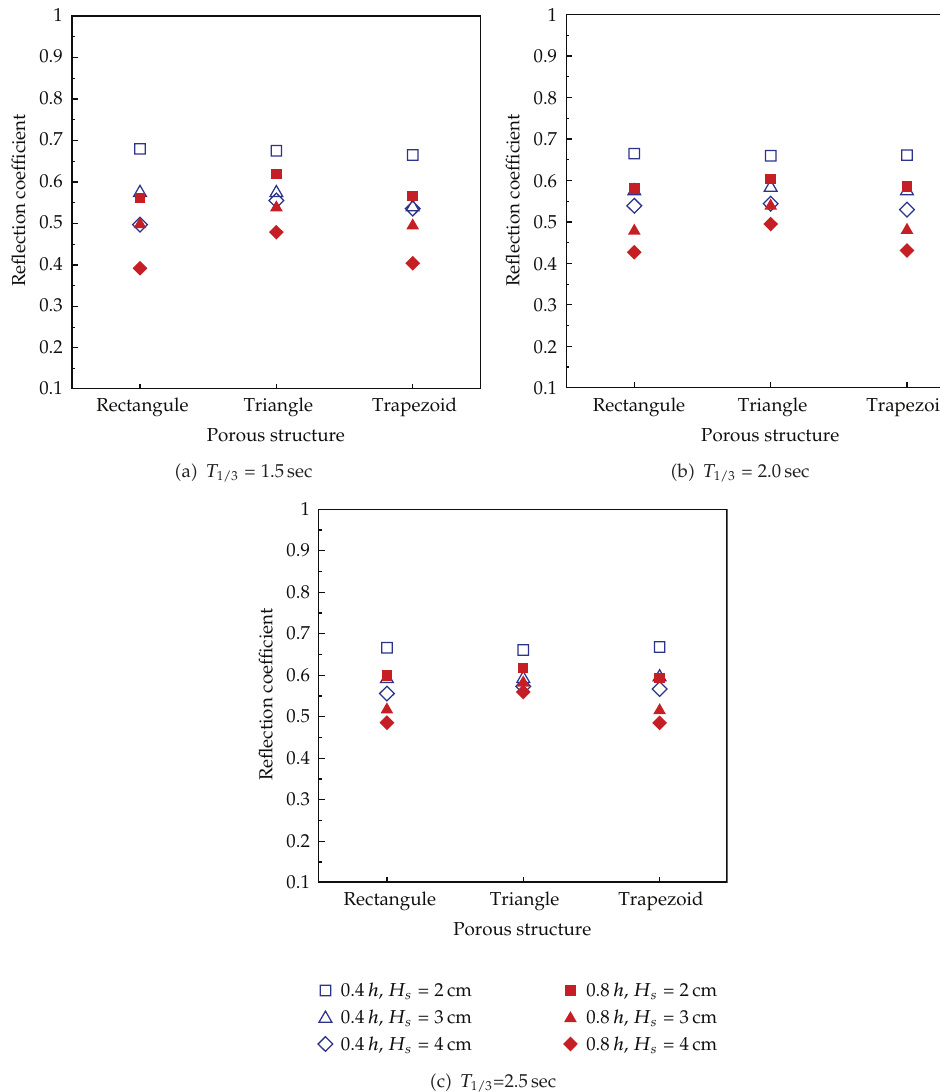
Figure 8: Reflection coe ffi cient for slit caisson with di ff erent shapes of porous